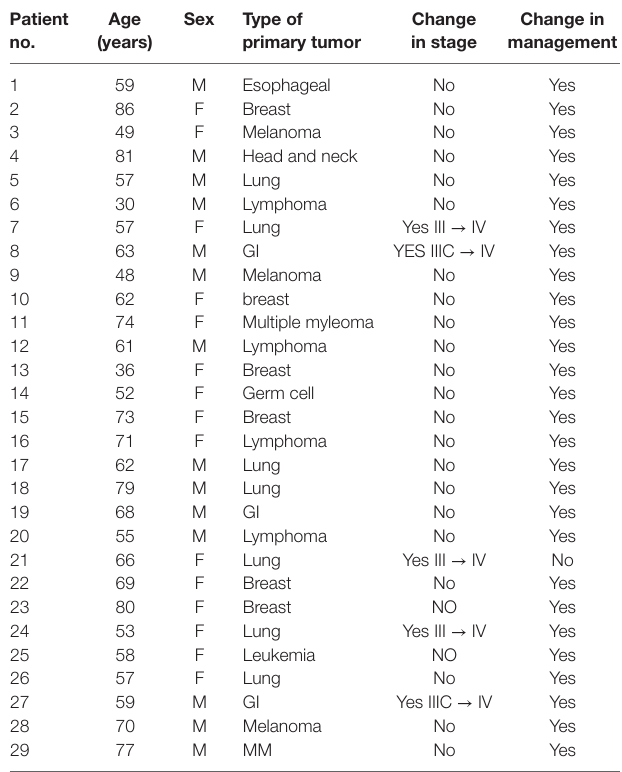
TaBle 1 | Patients in whom the detection of PeT-positive cT-negative sM change staging and/or management. Patient